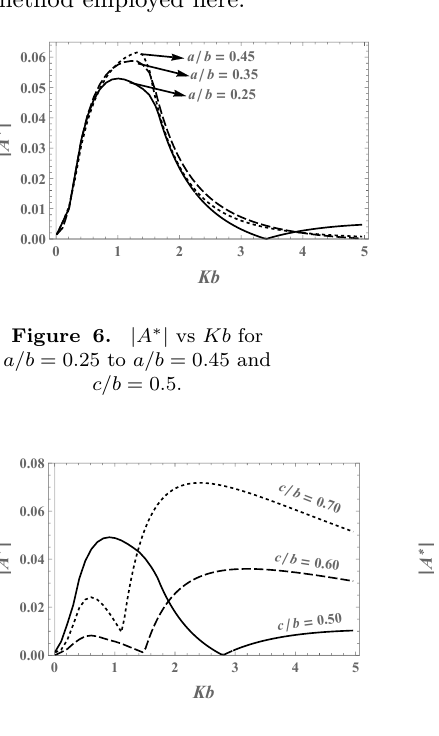
Figure 8. | A ∗ | vs Kb for a/b = 0 . 2 for different values of c/b .